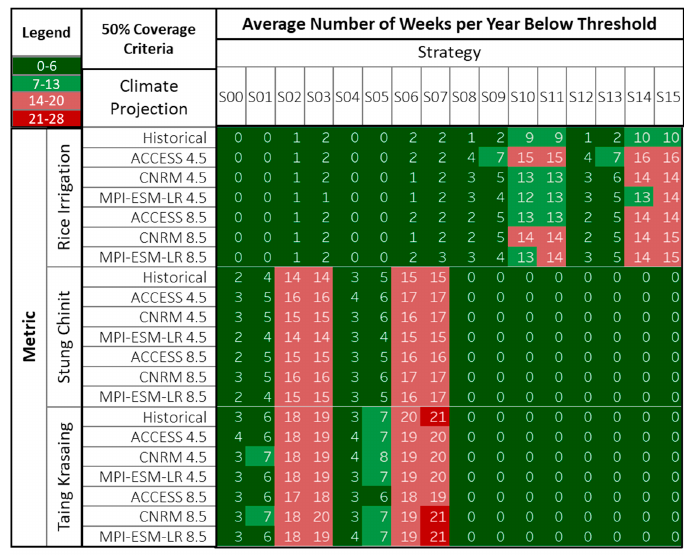
Figure 14. Average number of weeks per year where coverage is less than 50% coverage criteria.